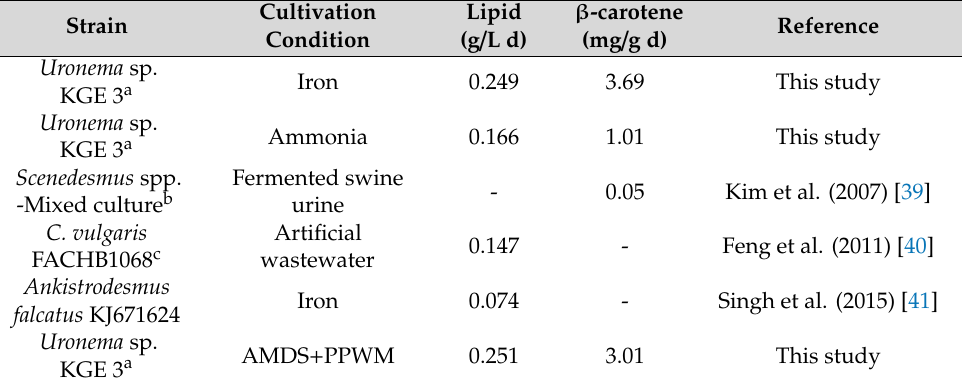
Table 2. Comparison of other researches for lipid and ß-carotene production. Cultivation Strain